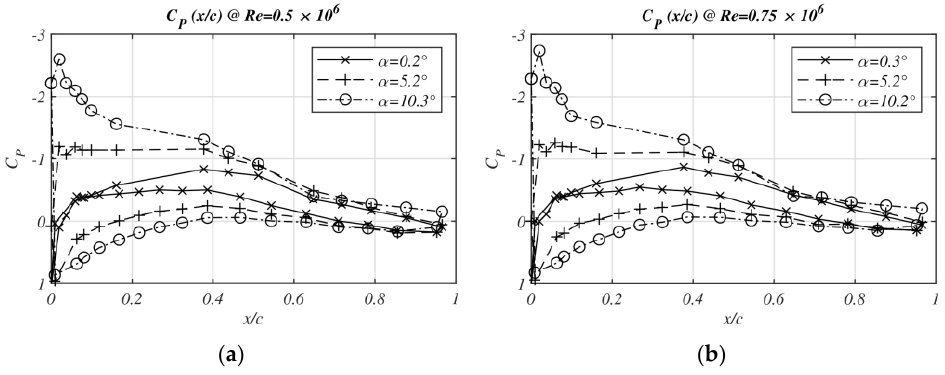
Figure 5. Pressure distributions at ( a ) Re = 0.5 × 10 6 and ( b ) Re = 0.75 × 10 6